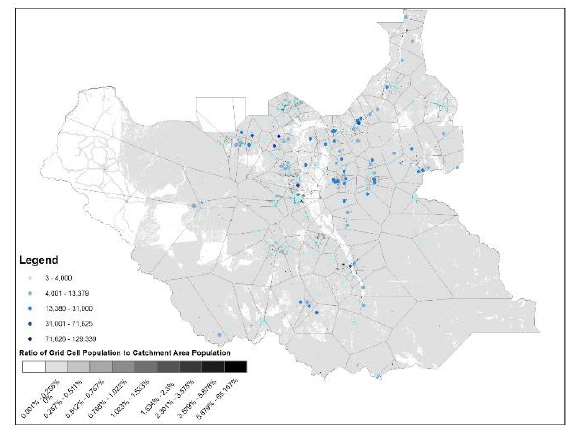
Figure 5. Thiessen Polygons for IDP Sites (December, 2015) and IDP Population by Catchment Area